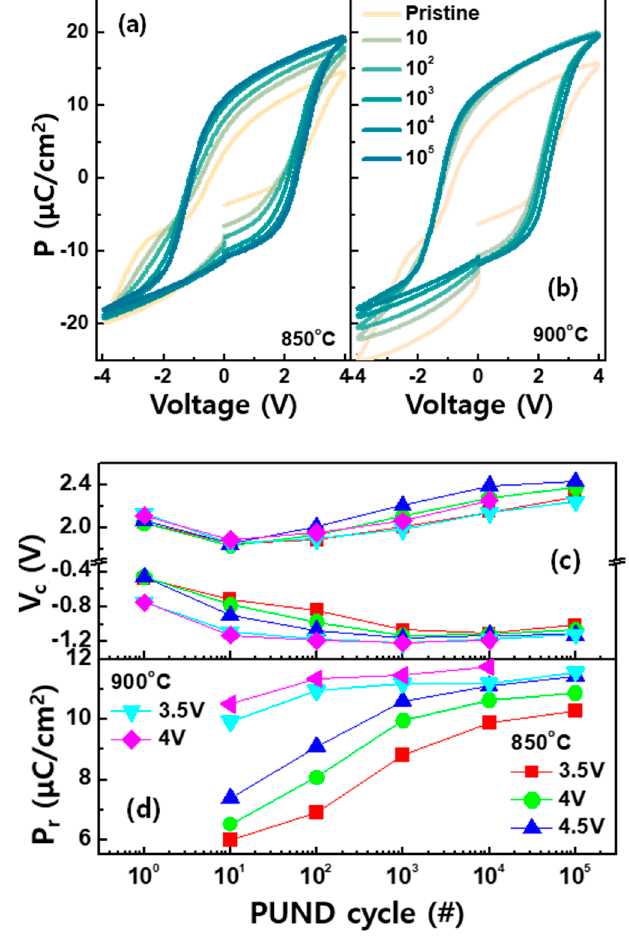
Figure 6. The P–V curves of the trilayer annealed at ( a ) 850 °C and ( b ) 900 °C. The extracted ( c ) ±V c and ( d ) P r as a function of the voltage amplitude of the PUND cycles.